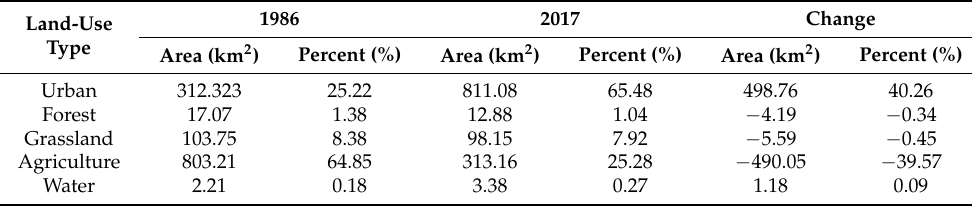
Table 3. Land use/cover changes in the study catchment from 1986 to 2017.